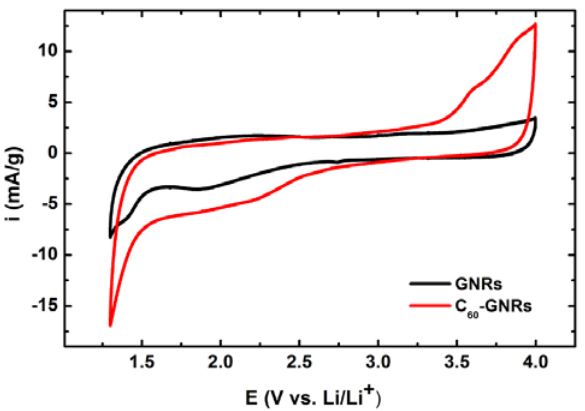
Figure 4 . Cyclovoltammograms for non-functionalized GNRs (black curve) and functionalized C 0.1